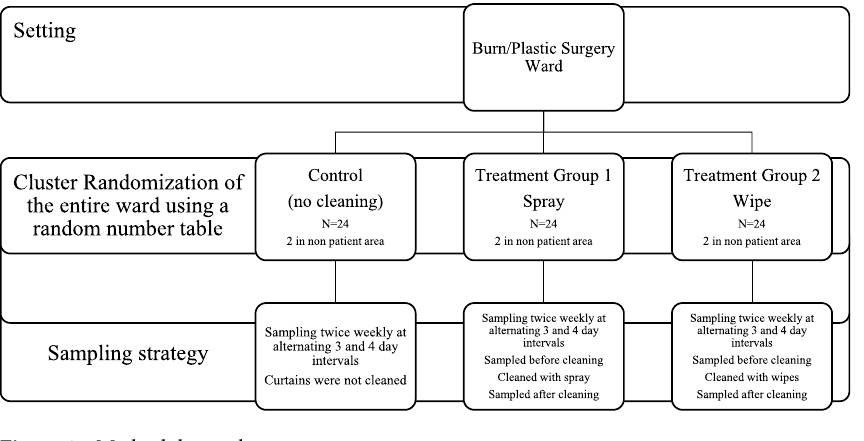
Figure 1. Methodology